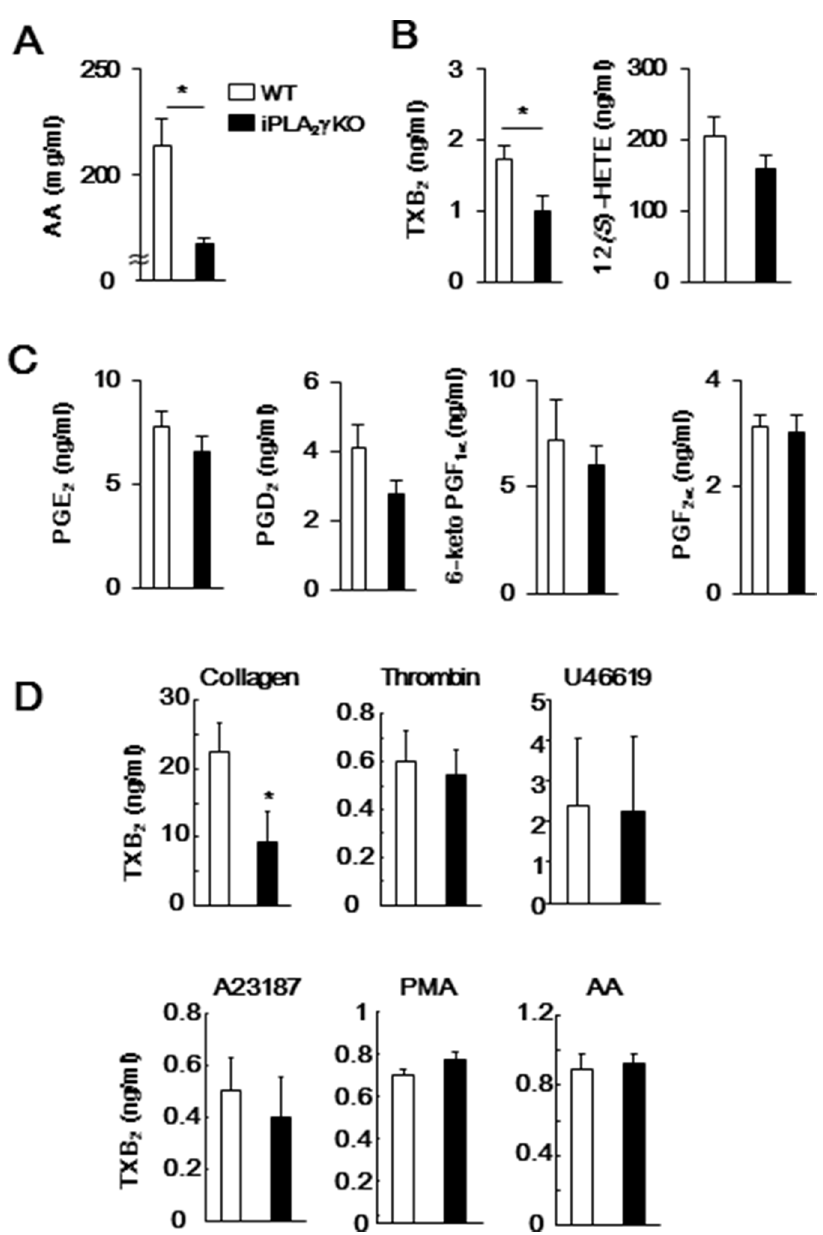
Figure 4. Amounts of lipid mediators produced from WT and iPLA 2 c -KO mouse platelets after ADP stimulation. Levels of (A) AA, (B) TXB 2 (a TXA 2 metabolite) and 12 (S) -HETE, and (C) PGE 2 , PGD 2 , 6-keto prostaglandin F 1 a (6-ketoPGF 1 a ) (a prostacyclin metabolite) and prostaglandine